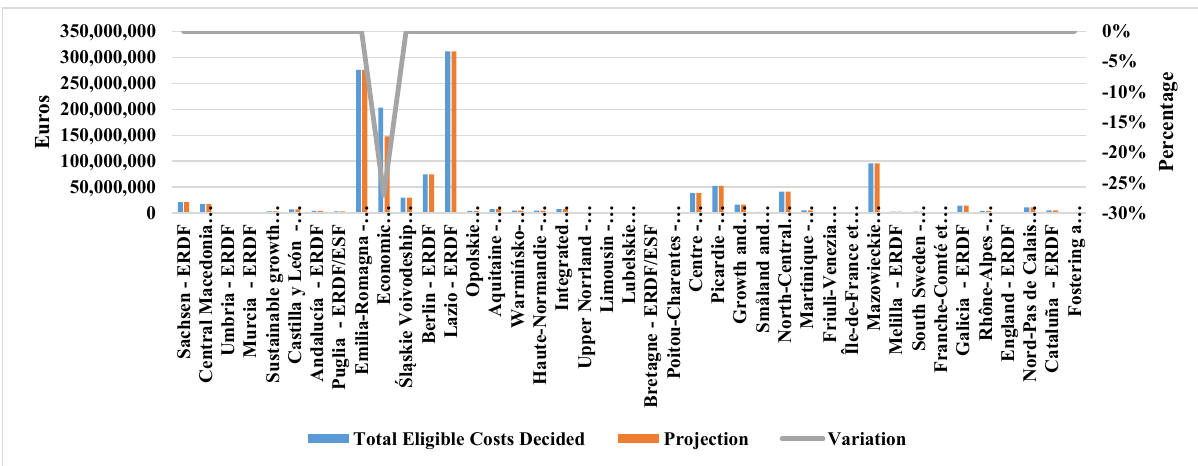
Figure 5. Potential input improvement for every inefficient OP. The “number of operations supported” shows the largest improvement potential of about 376% (i.e., it should increase on average from 189.54 to 902.34), while “eligible costs decided” ( − 8%) and “eligible spending” (17%) only require mild adjustments—see Table 8 and Figures 4 and 5.